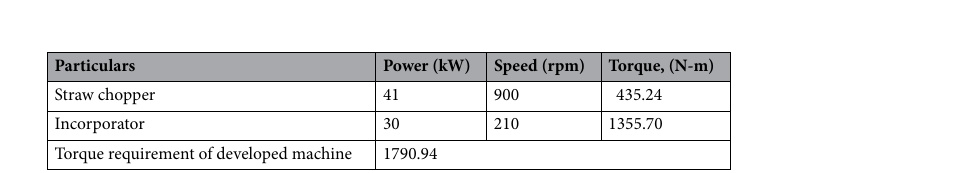
Table 1. Torque requirement of straw chopper cum incorporator.